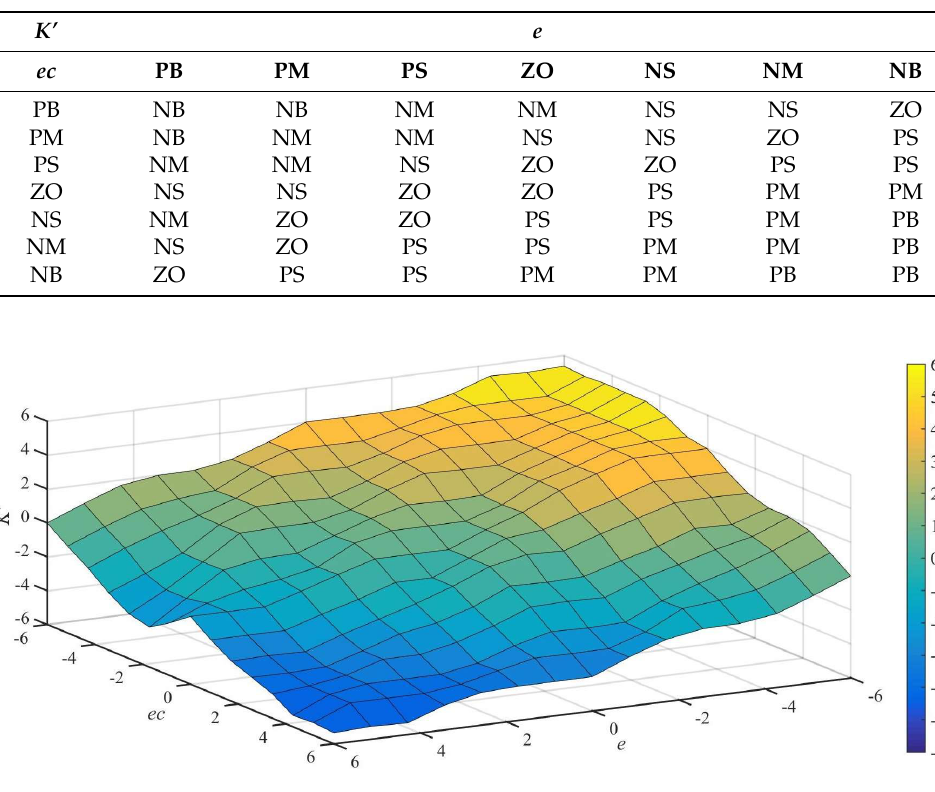
Figure 4. K’ output space surface.